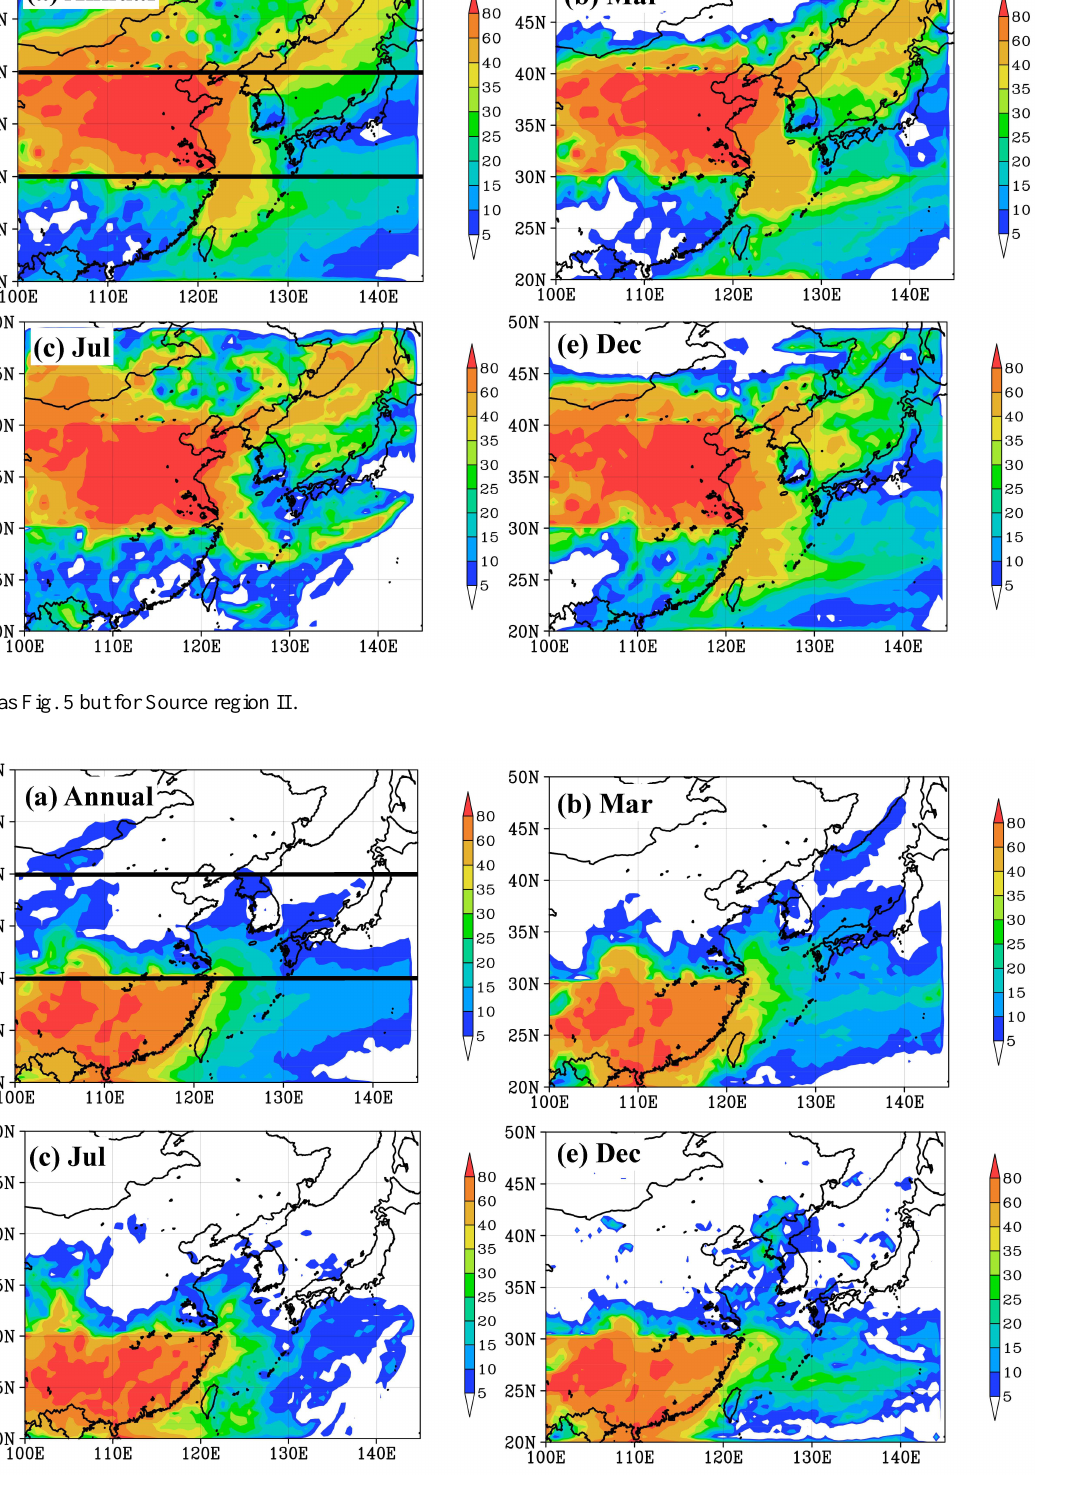
Fig. 7. Same as Fig. 5 but for Source region